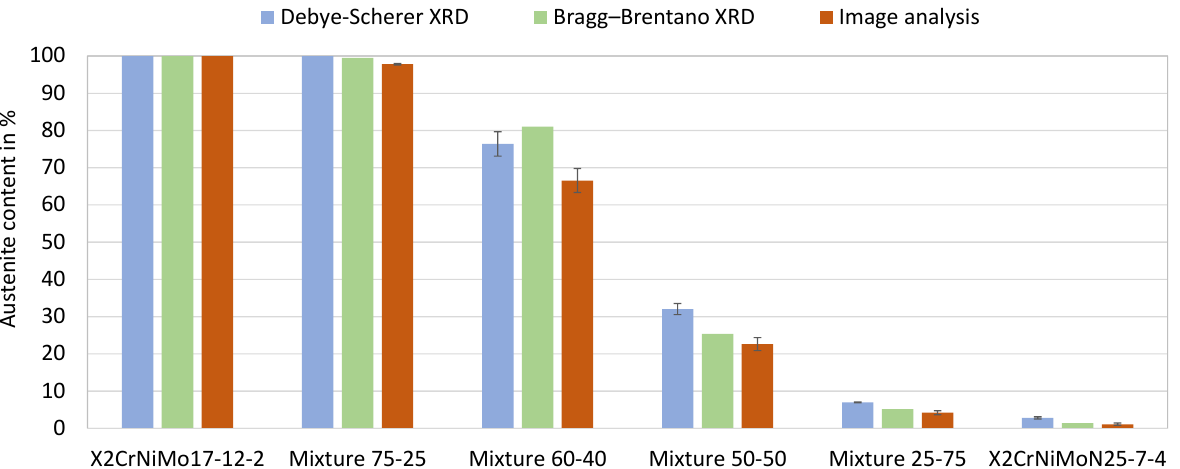
Figure 11. Phase fractions in the as-built duplex stainless steels. The parts were built under the standard process condition (Laser power 250 W, laser scan speed 800